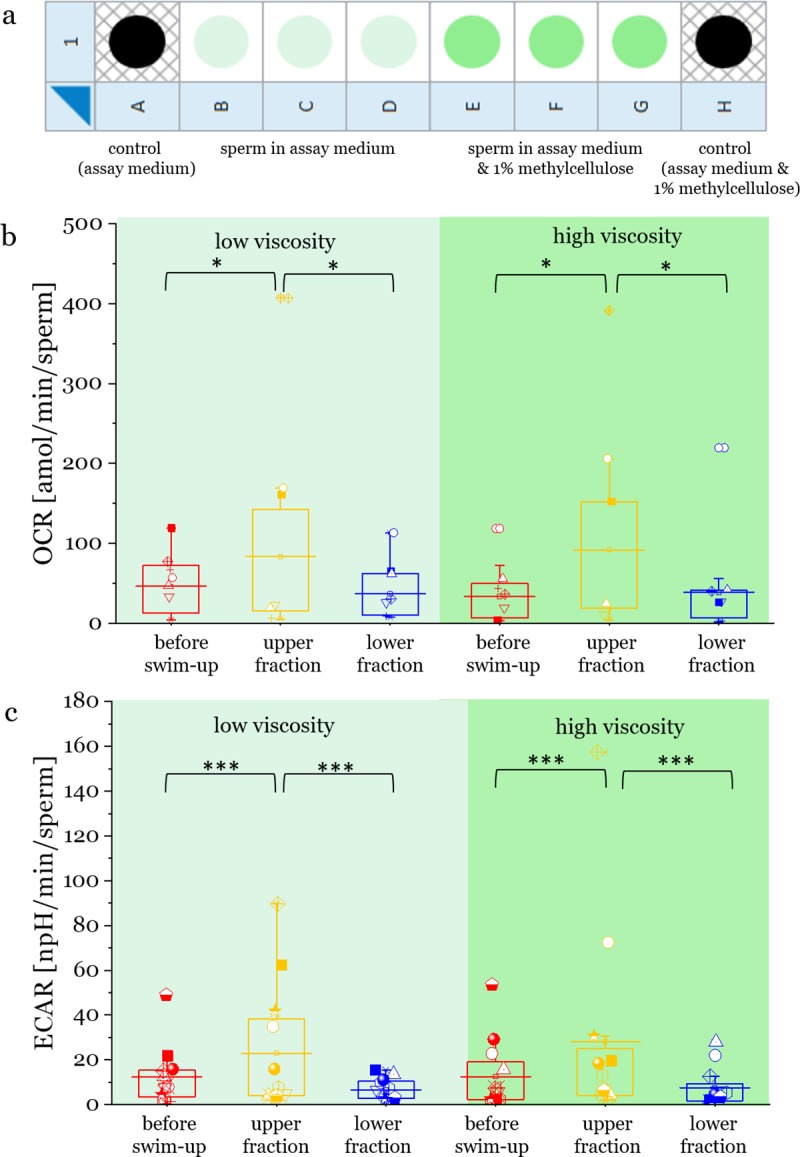
Oxygen consumption rate (OCR) in low viscosity medium (Assay Medium, indicated as light green) and high viscosity medium (Assay medium supplemented with 1% MC, indicated with darker green) of bull sperm after undergoing the swim-up procedure in low viscosity sperm medium SP-TALP. a) Schematic of the sample distribution in the 8 well plate. This triple-well measurement was performed on each fraction (upper, lower and before swim-up) and two control wells with the two levels of viscosity were used as background level. b) Oxygen consumption rate (OCR) and c) extracellular acidification rate (ECAR) for the before swim-up sperm, the upper and lower swim-up fractions of 12 bulls of three different breeds (Holstein, Fleckvieh, Angus) in two levels viscosity (labelled with light and dark green background). The horizontal lines across the boxes display the median values. The upper fraction shows significantly higher OCR (OCR, p = 0.02) and ECAR (p = 0.00019) compared to the lower fraction and before swim-up. Viscosity does not change the OCR or ECAR values significantly.